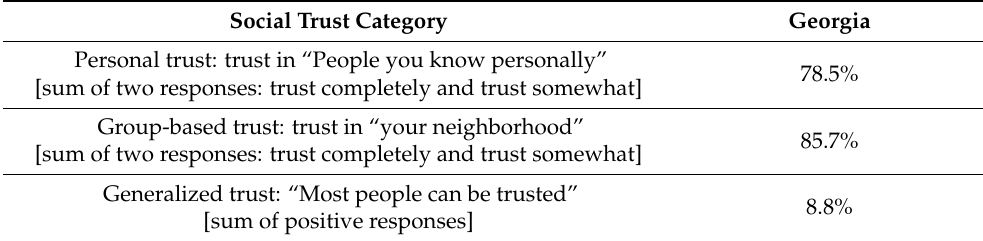
Table 1. Social trust in Georgia (World Values Survey Association 2021).